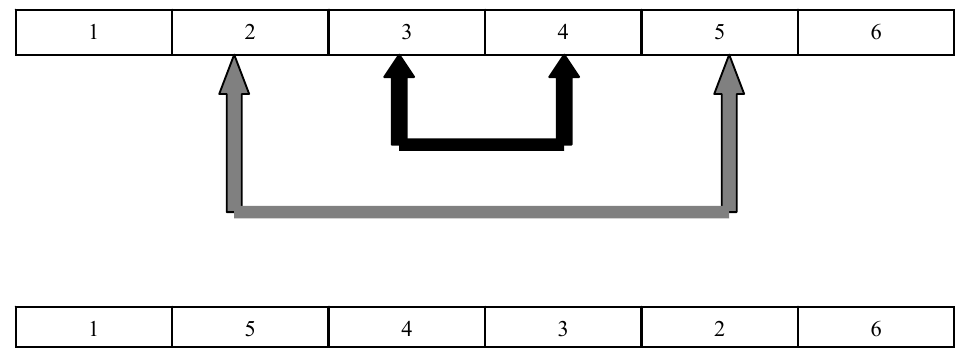
Figure 3. The Inversion mutation